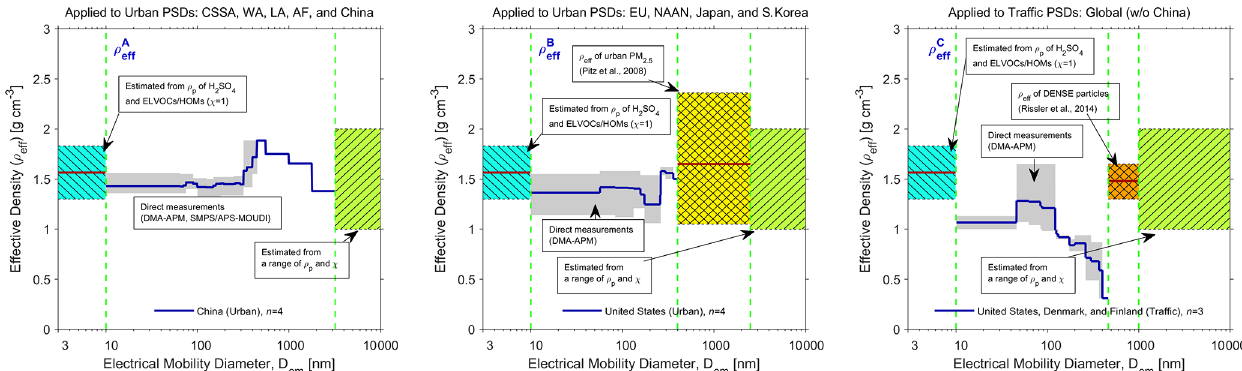
Figure 1. Size-resolved urban aerosol effective density functions ( ρ eff ) for Group A (“urban”; obtained from measurements in China), Group B (“urban”; obtained from measurements in the United States), and Group C (“traffic”; obtained from measurements in the United States, Finland, and Denmark). Details of the ρ eff measurements are summarized in Table S2. ρ eff values for different combinations of χ and ρ p are illustrated in Fig. 2. Measurement technique nomenclature: DMA: differential mobility analyzer, APM: aerosol particle mass